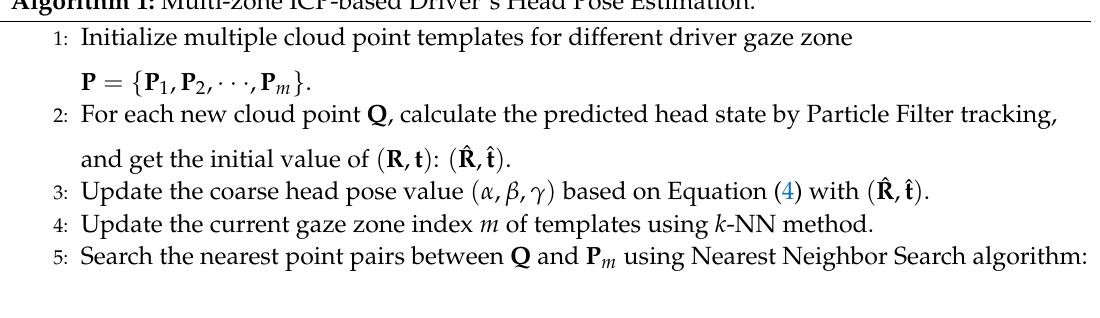
Algorithm 1: Multi-zone ICP-based Driver’s Head Pose